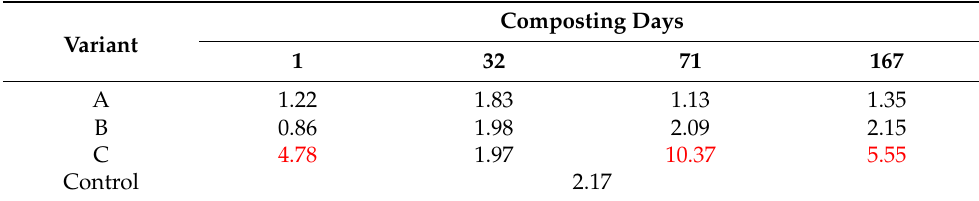
Table 3. Lettuce yield obtained from seedlings after 20 days of experiment (grams per pot, mean